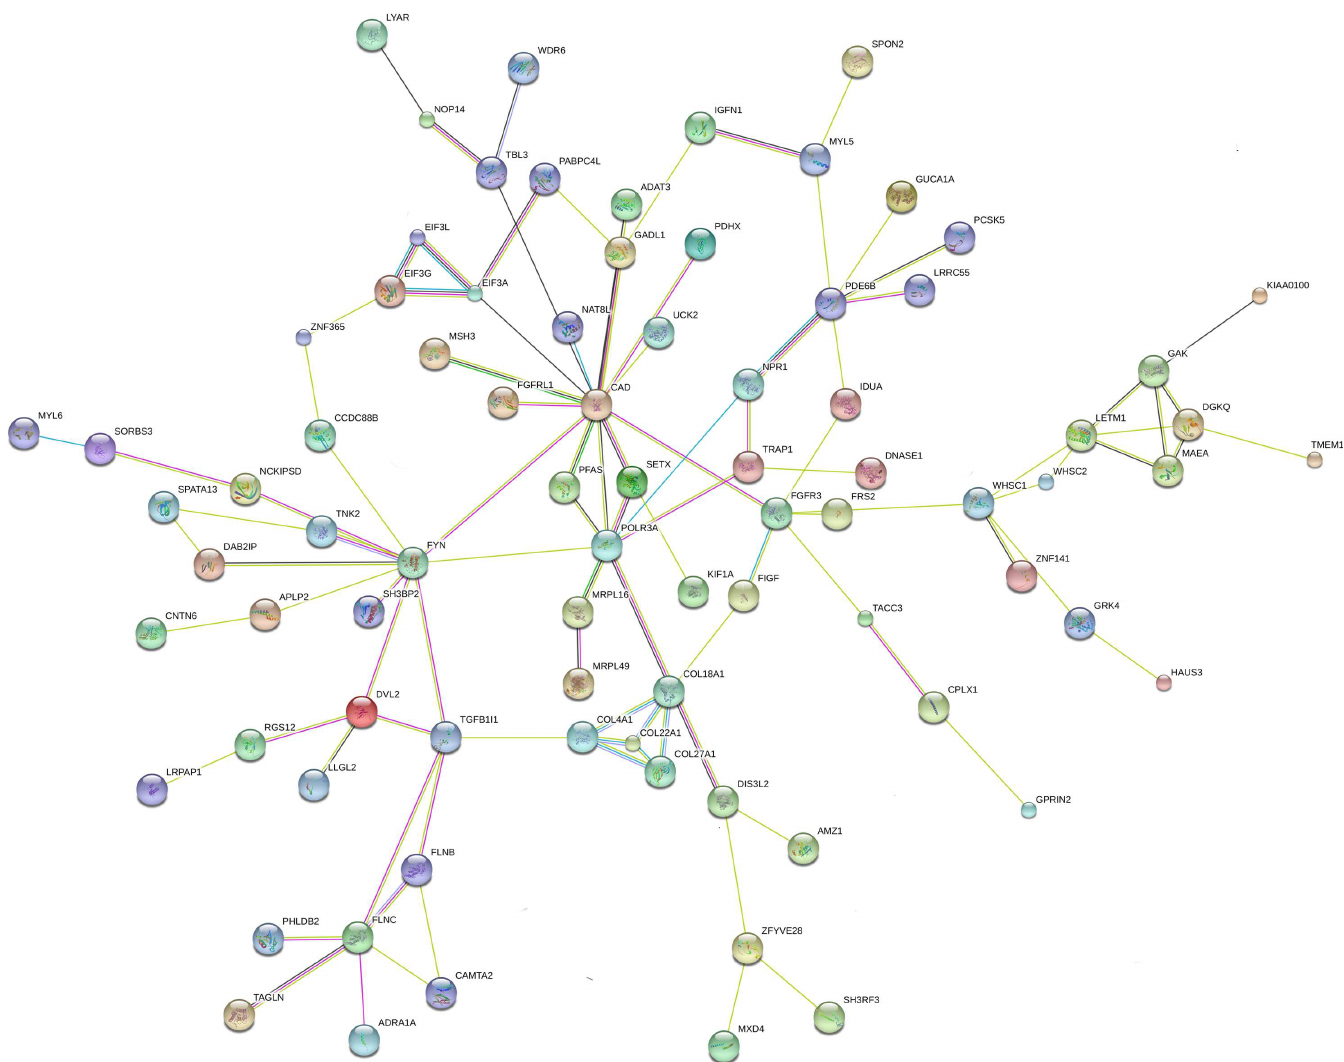
Fig 4. Male sibling STRING network analysis. Biggest componentof the connectingbrain-expressed genes present in the unbalanced translocation, altered by the shared and exclusive rare inheritedSNV and indels found in the male